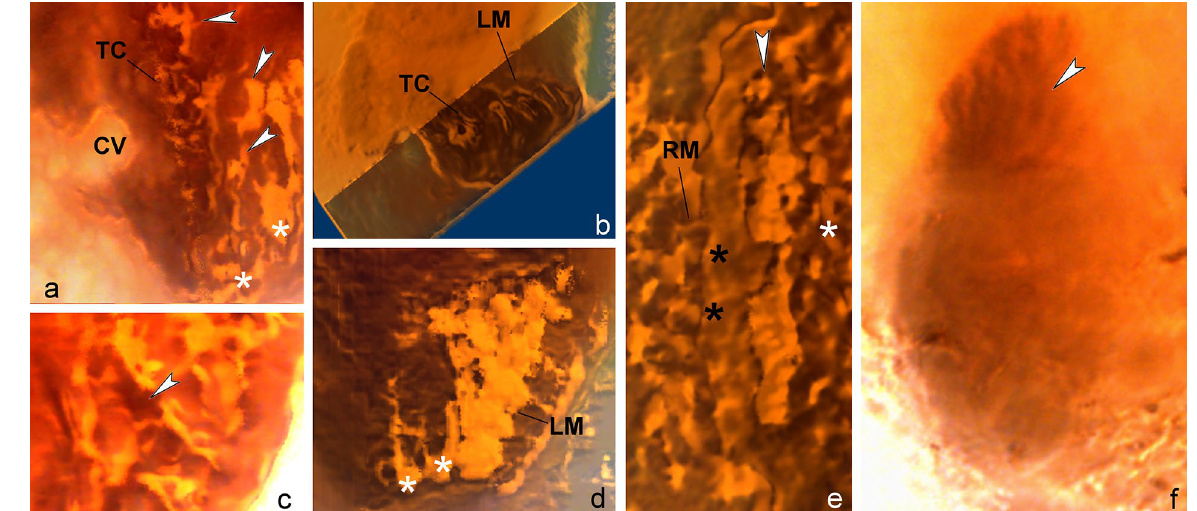
Figure 4. Volumetric reconstructions of Palaeohypothrix bahiensis gen. et sp. nov. holotype. ( a ) Posterior right quadrant of body showing undetermined surface structures (arrowheads) and part of the two ciliary brushes located between transverse cirri-like structures and left marginal ciliary brushes (asterisks). ( b ) Transversal section showing insertion of transverse cirri-like structures and left marginal ciliary brushes. ( c ) Insertion pores of left marginal ciliary elements (arrowhead). ( d ) Remnants of left marginal ciliature. Asterisks mark two ciliary brushes located between transverse cirri-like structures and left marginal rows set. ( e ) Detail of right margin of body. Black asterisks show putative marginal cirri; white asterisk shows supposed pellicular pores. Arrowhead points to rightmost ventral brush. ( f ) Dorsal side with arrowhead pointing to cortical ribs. Legends: CV contractile vacuole, LM left marginal ciliature, RM right marginal ciliature, TC transverse cirri-like